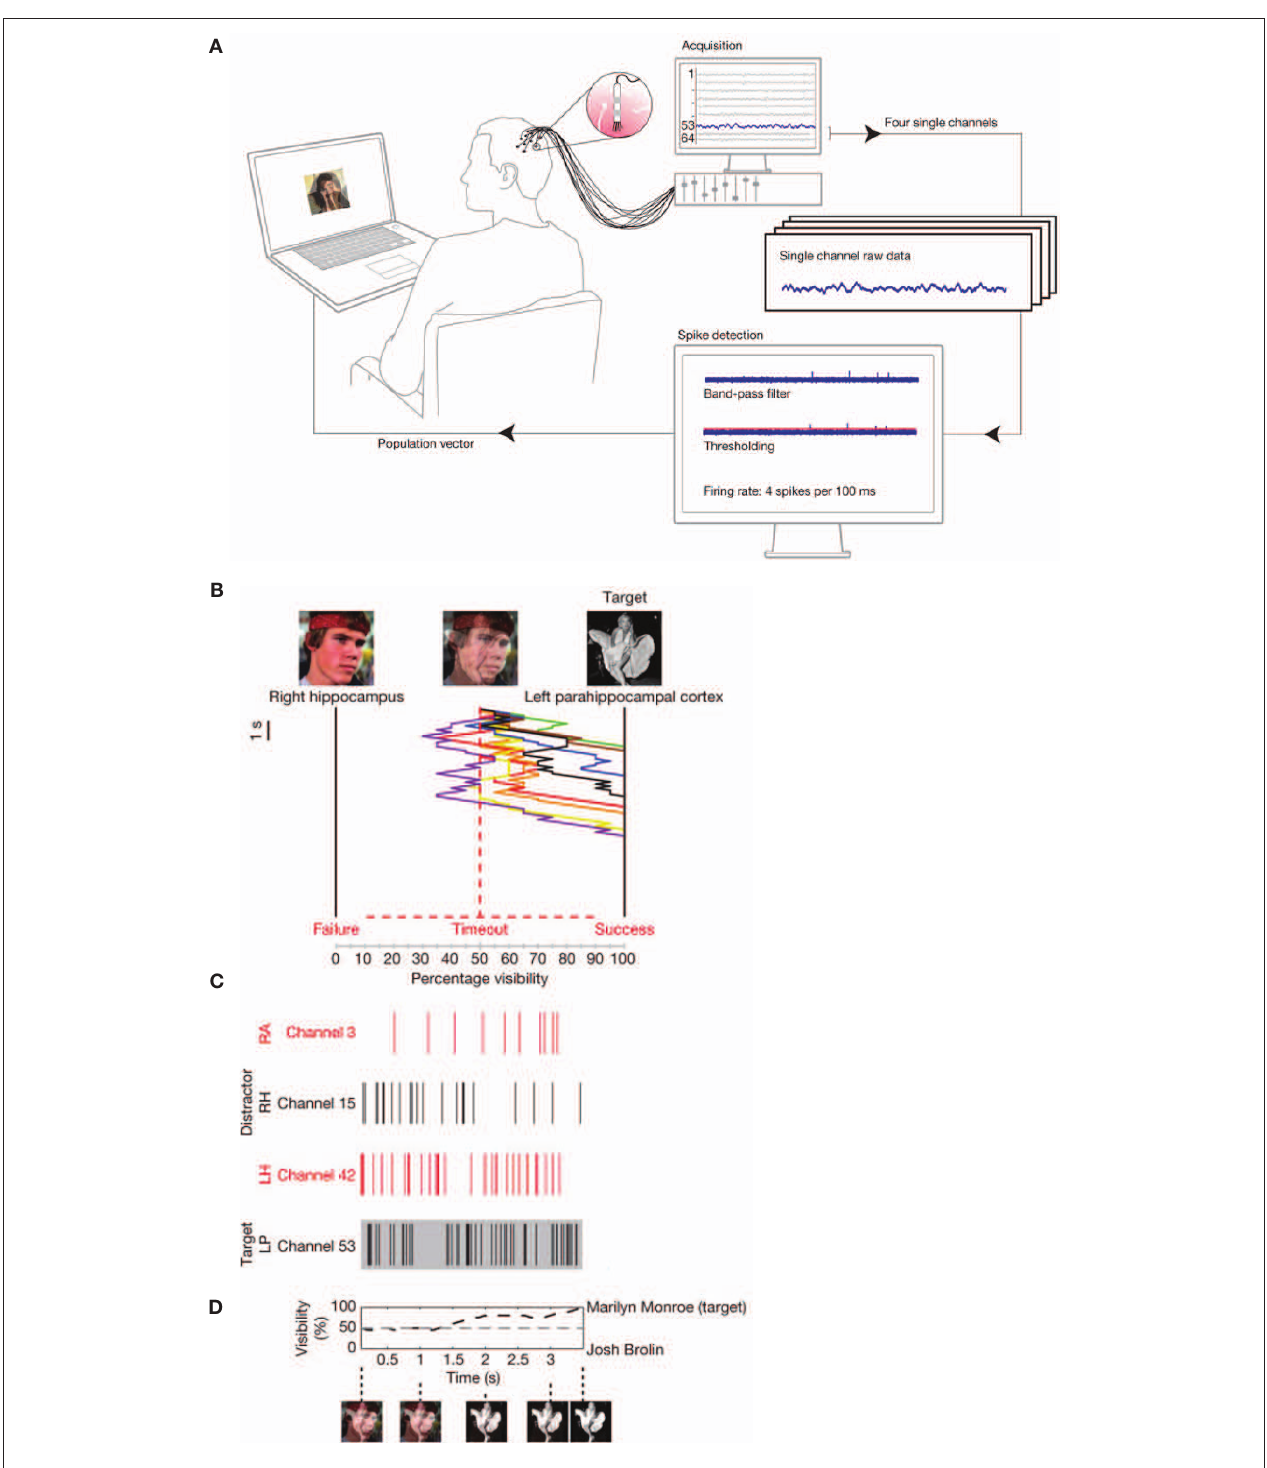
Figure 5 | Online control of the firing of temporal lobe neurons. (A) Electrodes allowing for detecting single unit firing were implanted in the temporal lobe of patients prior to surgery. The firing of multiple neurons was analyzed online. The output of the analysis controlled a visual display. (B) In the visual display photos of famous persons (e.g., Marilyn Monroe and Josh Brolin) were superimposed. Subjects were asked to attend to one